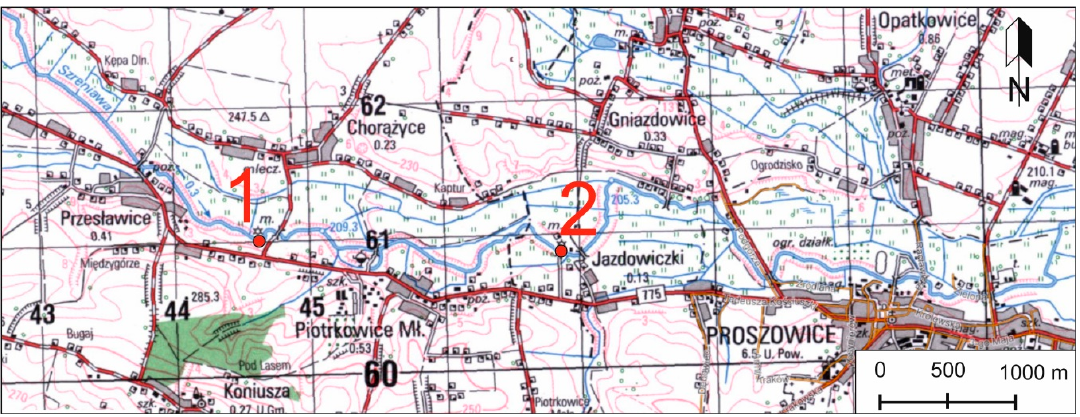
Figure 4. Location of potential SHPP Jaksice (1) and Jazdowiczki (2).